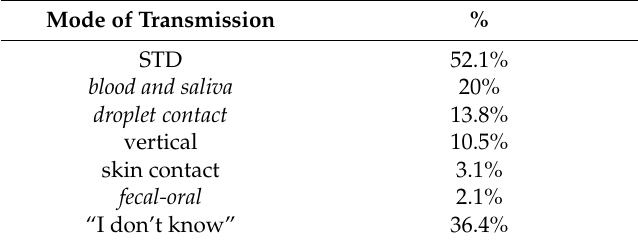
Table 2. Distribution of answers concerning the mode of transmission of HPV infection.